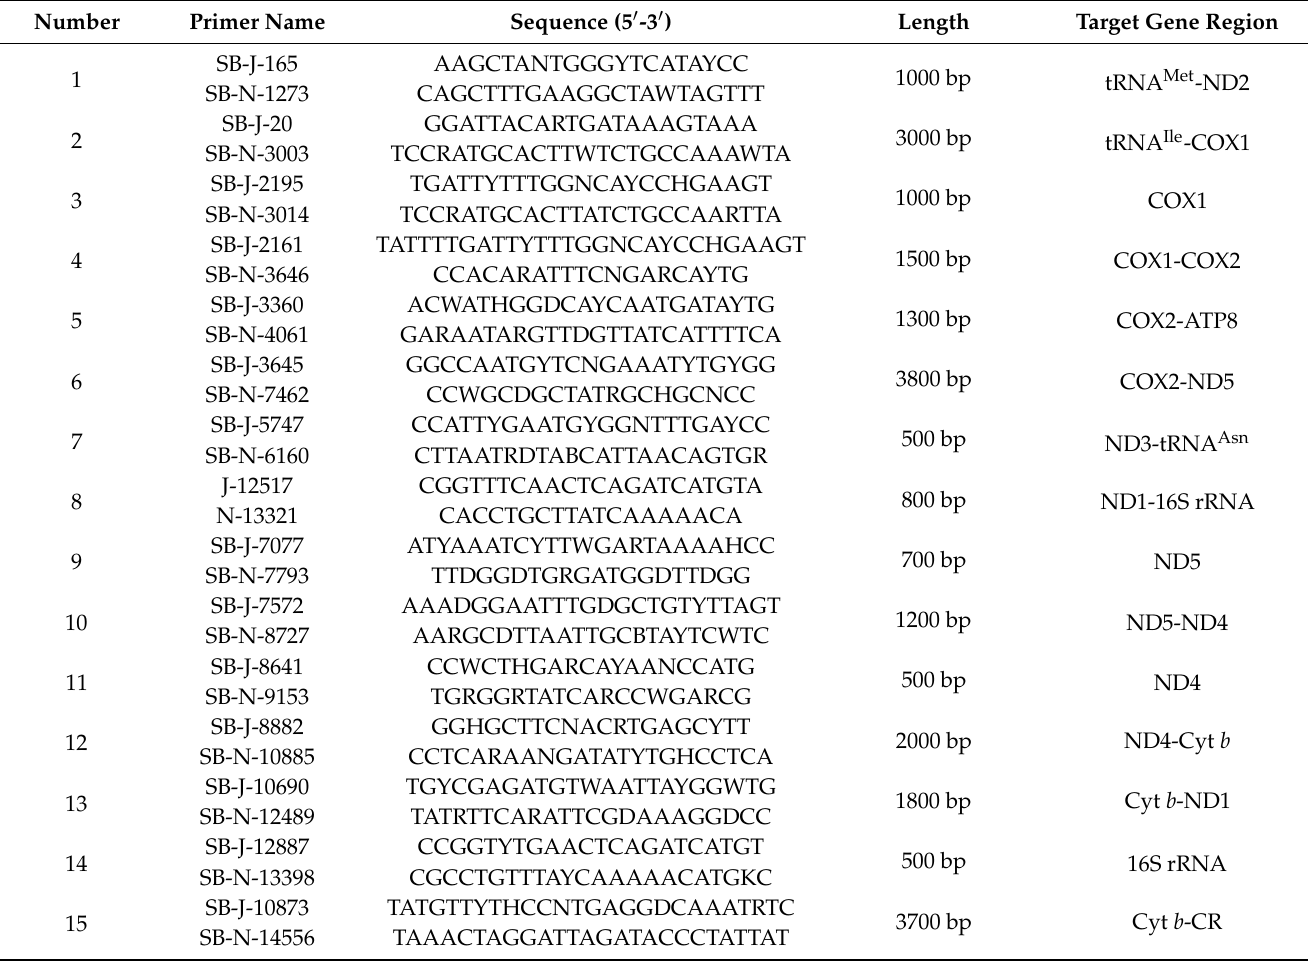
Table 1. List of universal primers used for PCR amplification according to Simon et al.